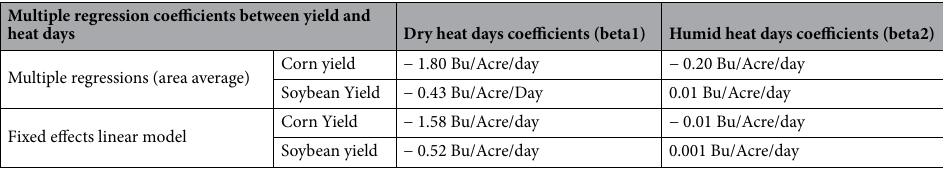
Table 1. Comparison of multiple regression between yield and heat days using two different methods. The first uses the area-averaged multiple regression across all non-irrigated stations using detrended yield data at each county and dry and humid heat days for all stations within that county (Fig. 3) and the second uses the space–time fixed effects linear model applied to non-detrended data for all non-irrigated stations (Eq. 3).